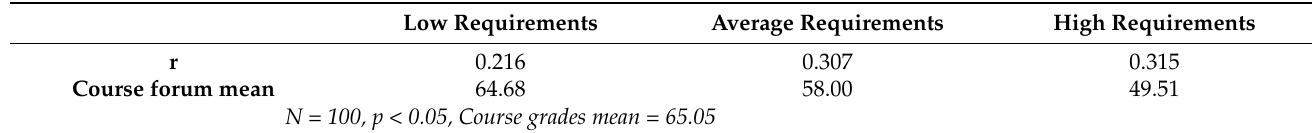
Table 7. Pearson’s correlation coefficient for top contributors only (Learners posting in the course forum AND attempting summative assessment activities).